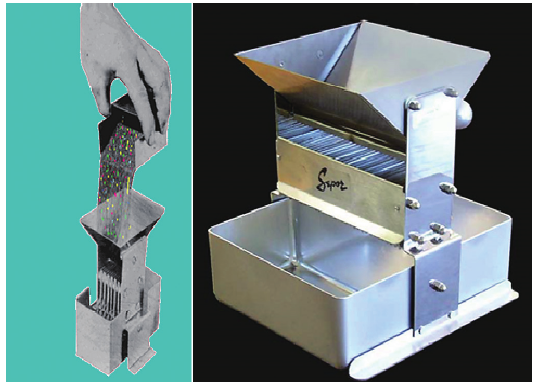
Fig. 4 A picture of Chute Rifflers. (Courtesy of Sepor, www.